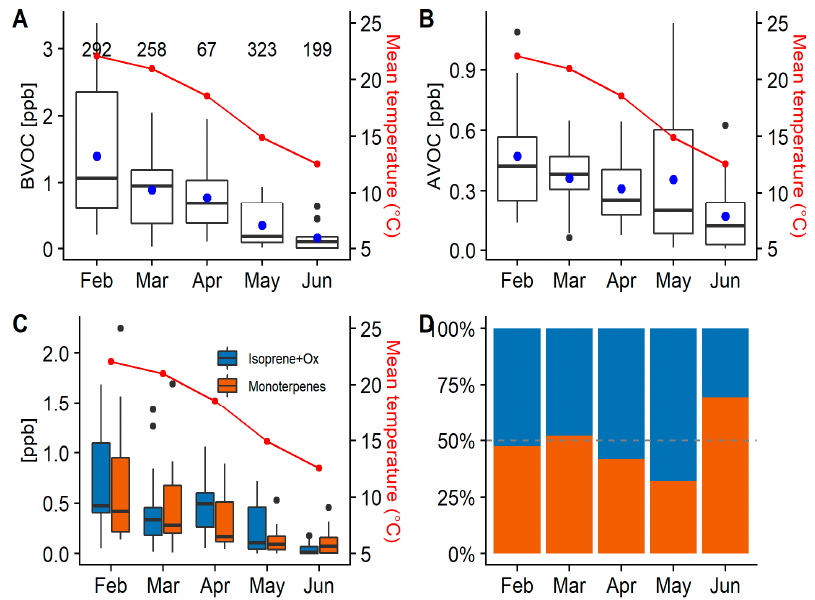
Figure 8. ( A ) Box plot showing the variation of the total daily mean targeted BVOC concentration per month, along with the monthly mean temperature (24 hrs) in red. The black line represents the median, the line on the box is the 95% of the distribution range and outliers are shown as black dots. The number on top of the box plots represents the number of samples per month in the analysis. The blue dot represents the overall mean concentration. ( B ) Box plot showing the total daily mean concentration of targeted AVOCs per month along with the monthly mean temperature in red. Most of the variability observed in May can be explained by periods of high advections and wind speed onsite. ( C ) Daily mean concentration box plot of the monoterpenes (orange) and the sum of isoprene and its oxidation products (blue). ( D ) Relative contribution of BVOC groups (Isop+ox; monoterpenes) estimated from the average concentration of each group divided by the sum of both groups per month.